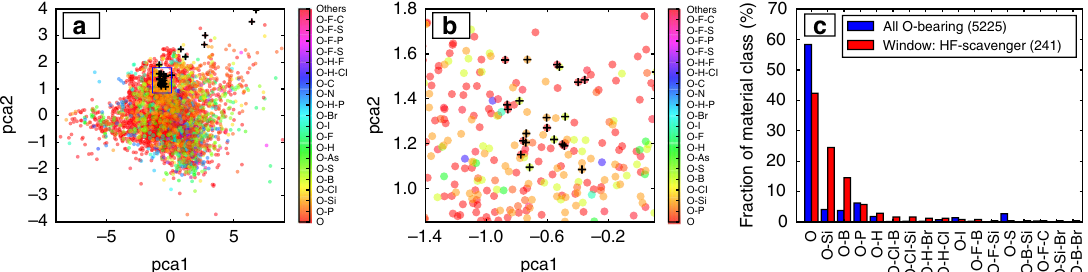
Figure 6 | Statistical analysis of effectiveness of material classes for HF-scavenging. ( a ) Principal component analysis (PCA) for HF-scavenger coating attributes for the B 5,200 thermodynamically stable oxides. The promising HF-scavengers listed in Fig. 5 are marked with a ‘ þ ’ sign, and their approximate region in the plot is highlighted by a rectangular window. This highlighted window is magnified in b . In c , we compare the distribution of material classes among all stable O-bearing compounds to that of all promising HF-scavengers from b . O-bearing compounds are exclusively classified on the basis of the (poly)-anion forming elements they have in addition to oxygen; namely, P, Si, Cl, B, S, As, H, F, I, Br, N and C. For example, compounds labeled as O do not include those labeled as O–P, and similarly O–H–P or O–F–P are not subsets of the O–P category. NATURE COMMUNICATIONS|7:13779|DOI: